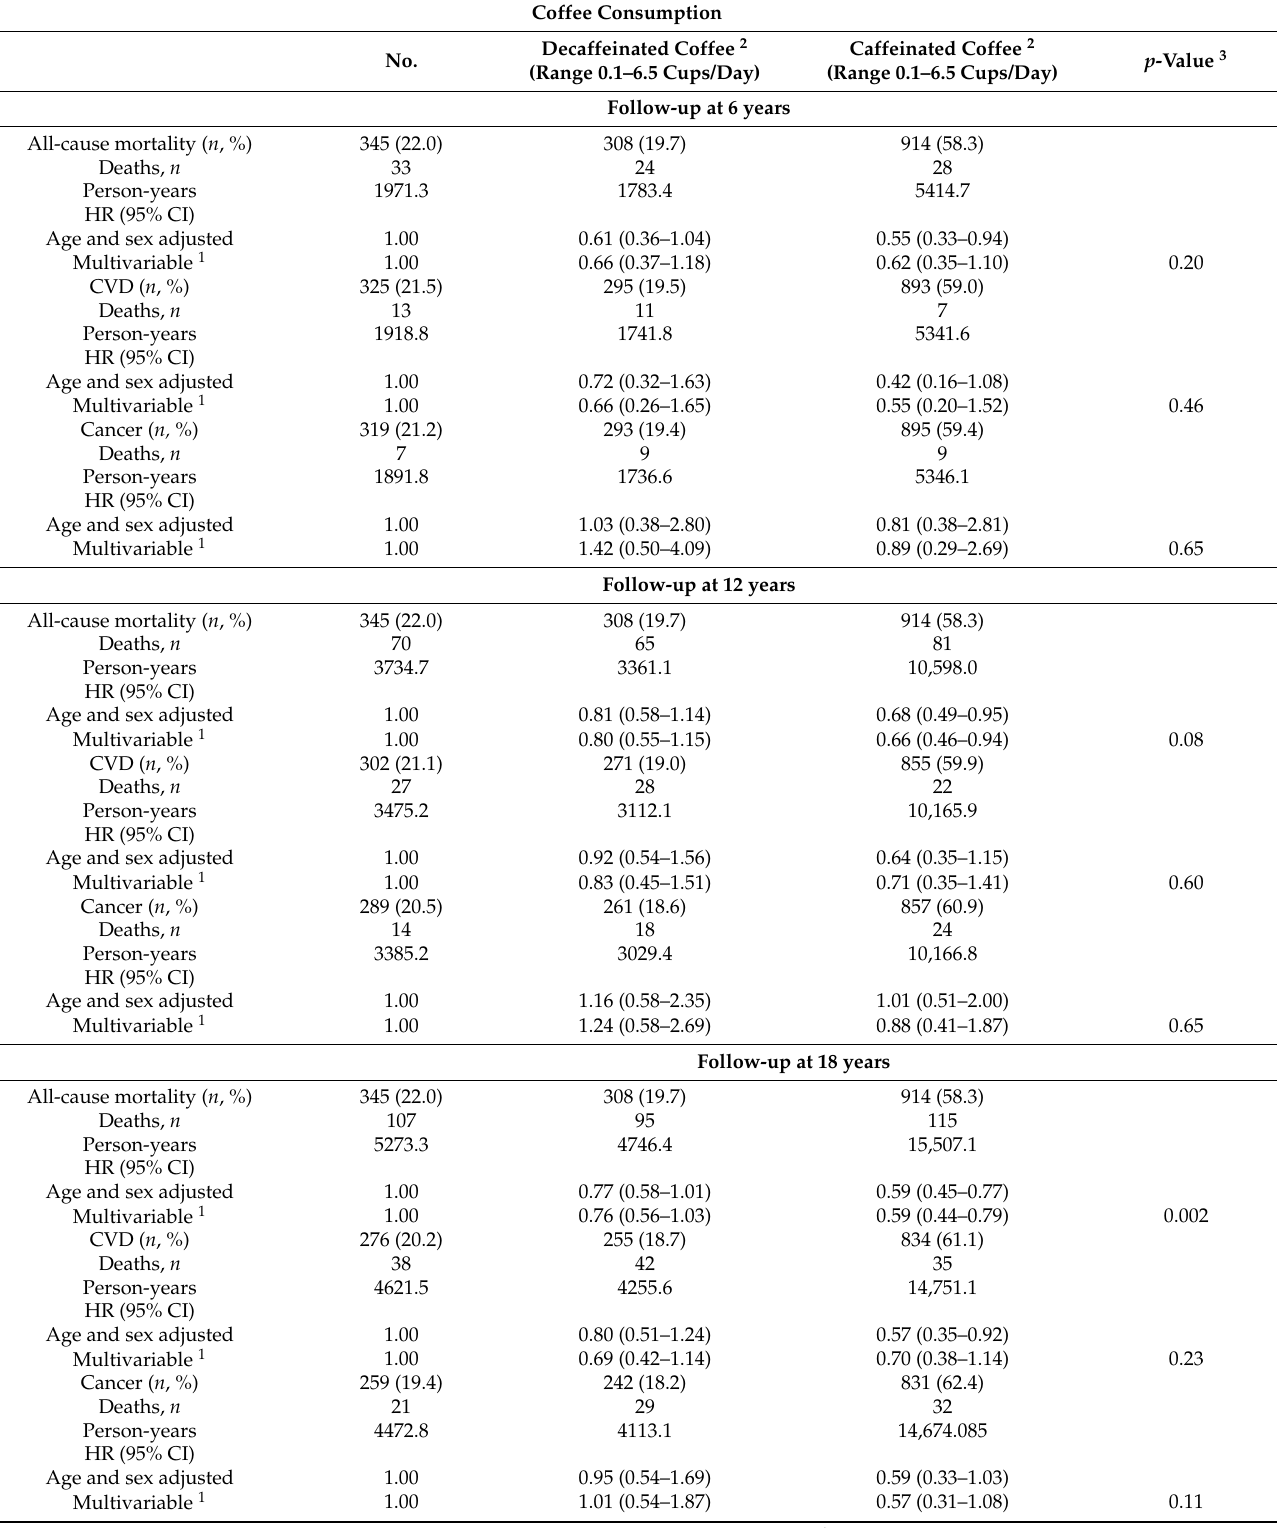
Table 3. Associations between type of coffee consumption and all-cause, cardiovascular disease, and cancer mortality among participants of the Valencia Nutrition Survey in